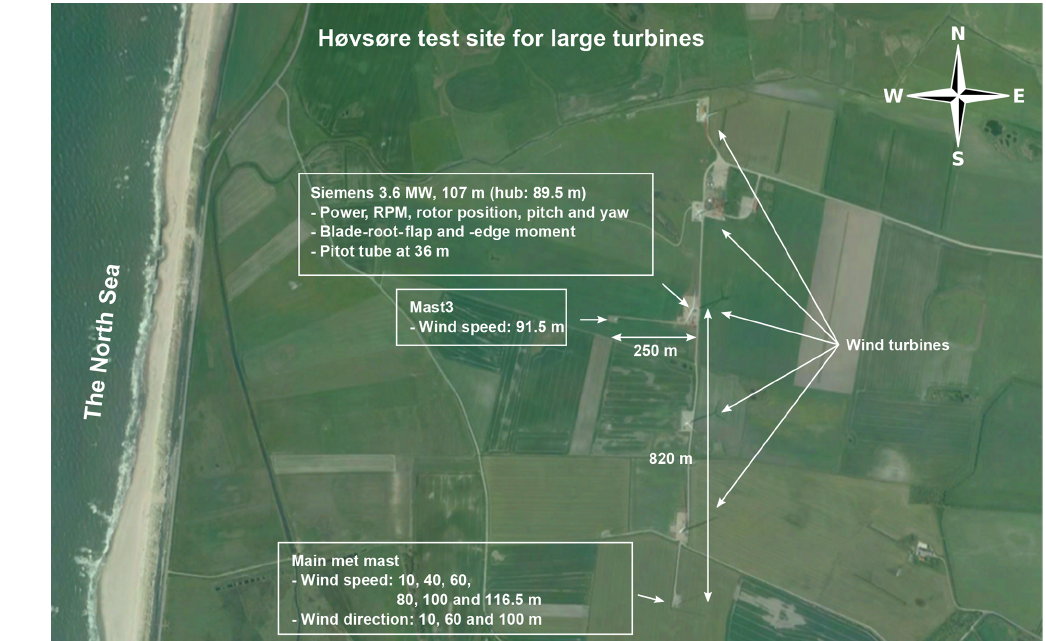
Figure 3. Overview of the Høvsøre test site for large wind turbines in Denmark. The Siemens turbine is located in the middle of a row of five megawatt